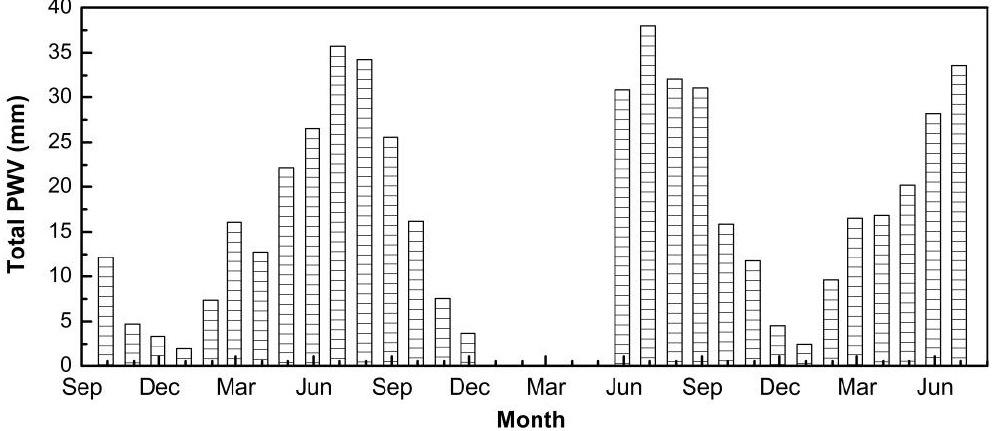
Figure 6. Seasonal variations in the total PWV from September 2013 to July 2016.